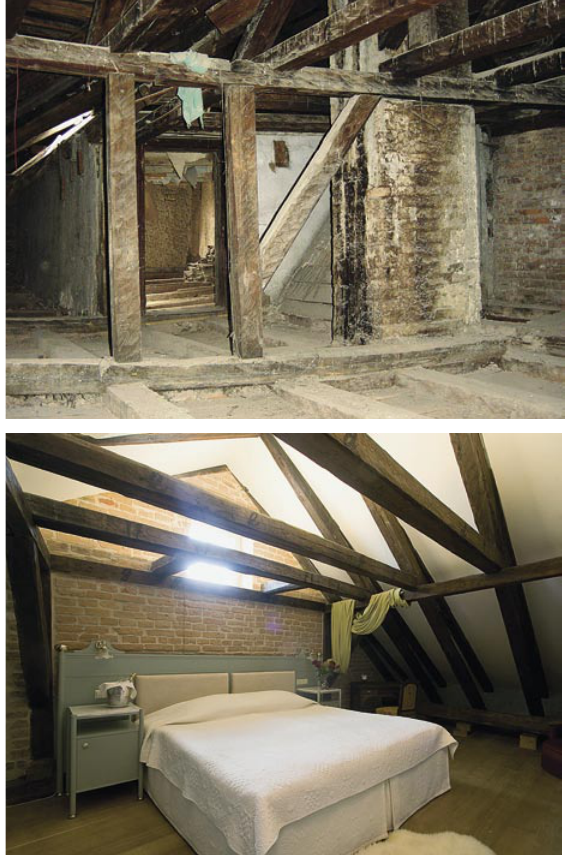
Fotod: Heikki Leis, Reet